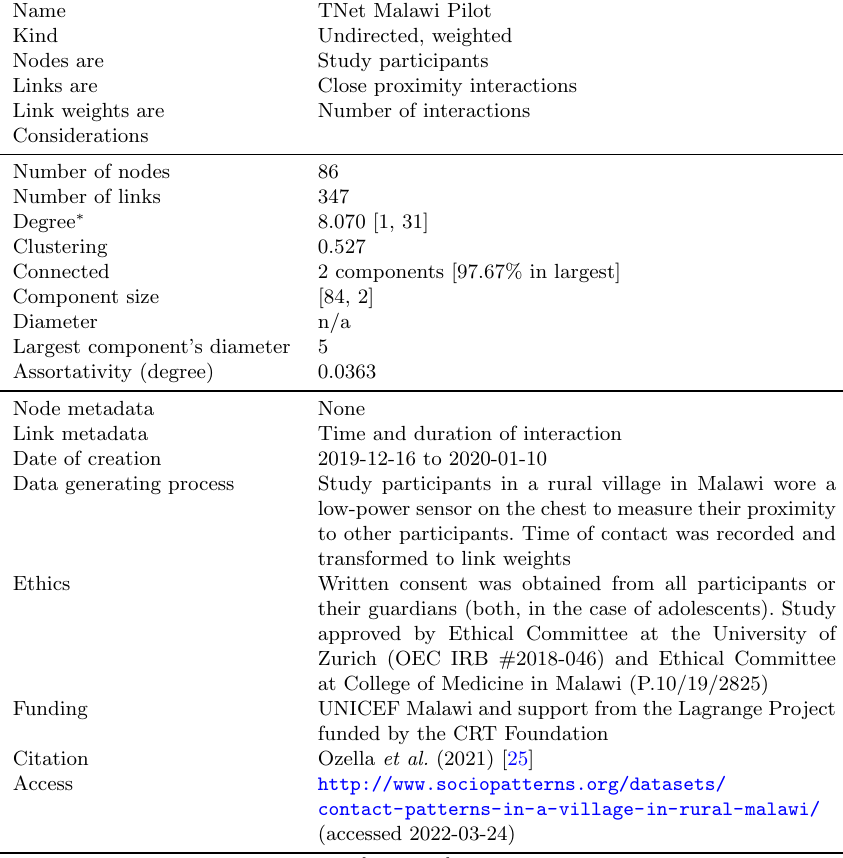
Table 3 Network card for a temporal contact (close proximity) network